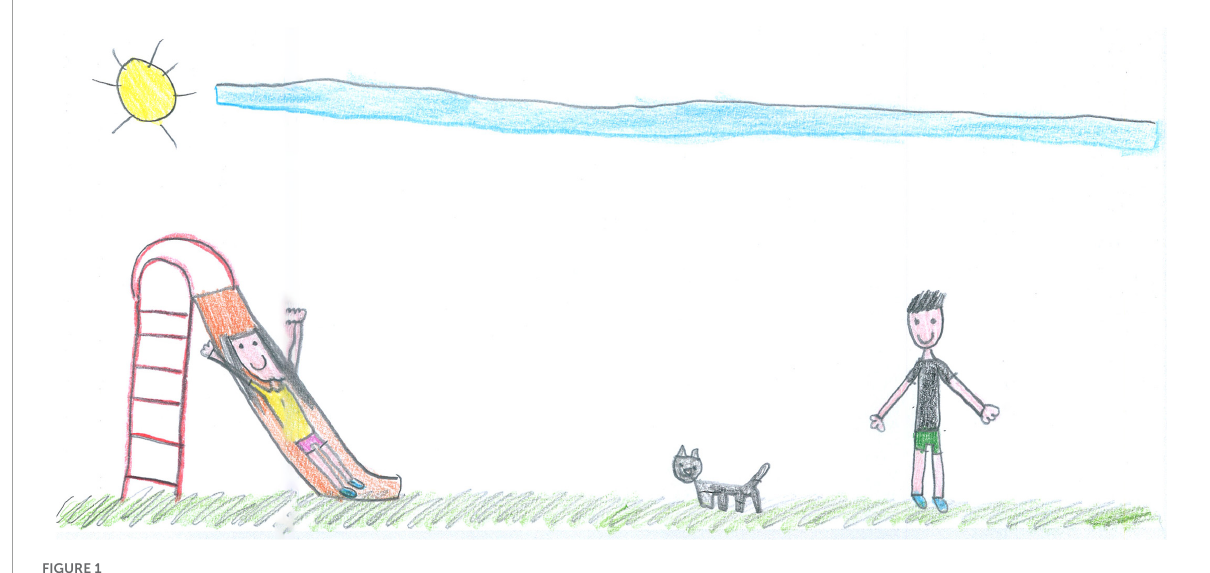
FIGURE1 A colorful representation with full body view and other people present (PS, Female, 7 years).